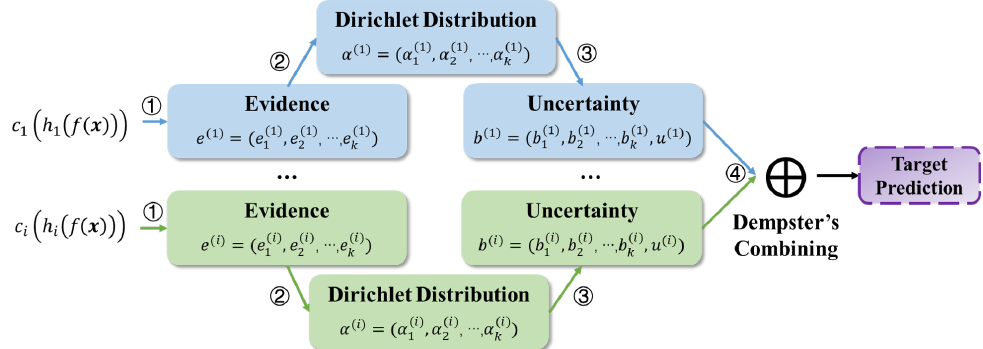
Figure 3. The process of combining the outputs of multiple domain-specific classifiers. Source domain task loss L cls is calculated here. To adapt to the Dirichlet distribu- tion [65], the cross-entropy function is formulated as